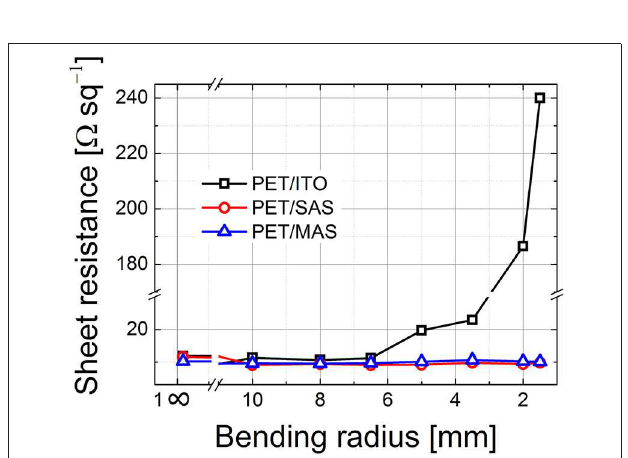
FIGURE 7 | Sheet resistance of PET/ITO, PET/SnO 2 ( ∼ 25nm)/Au (10nm)/SnO 2 ( ∼ 15nm) (SAS) and PET/MoO x (18nm)/Au (10nm)/SnO 2 ( ∼ 15nm) (MAS) electrodes after cyclic bending (50 times, tensile stress) at several curvature radii; bending was achieved by conforming the electrodes to cylinders of known diameter, with the non-conductive side in contact with the cylinders.